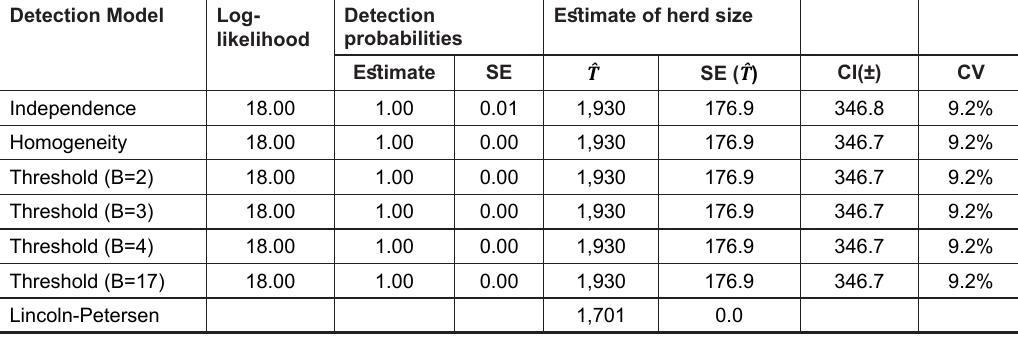
Table 46. Rivest model estimates and LP estimate for the 2015 Tuktoyaktuk Peninsula herd post calving survey. Detection Model Log- Detection probabilities likelihood